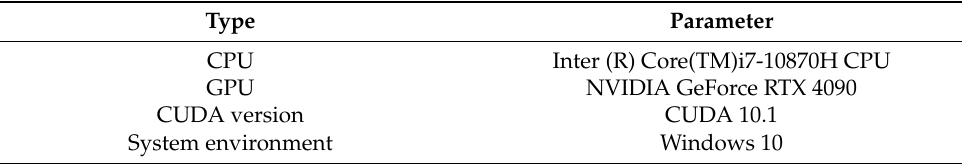
Table 1. Hardware Table 1. Hardware configuration. Table 1. Hardware configuration.